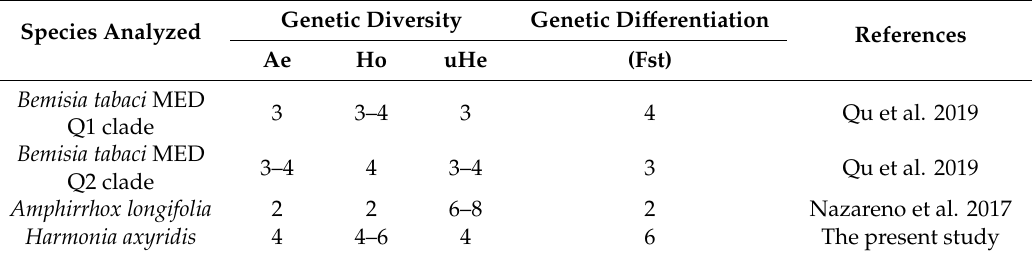
Table 1. The optimal sample sizes required for di ff erent genetic